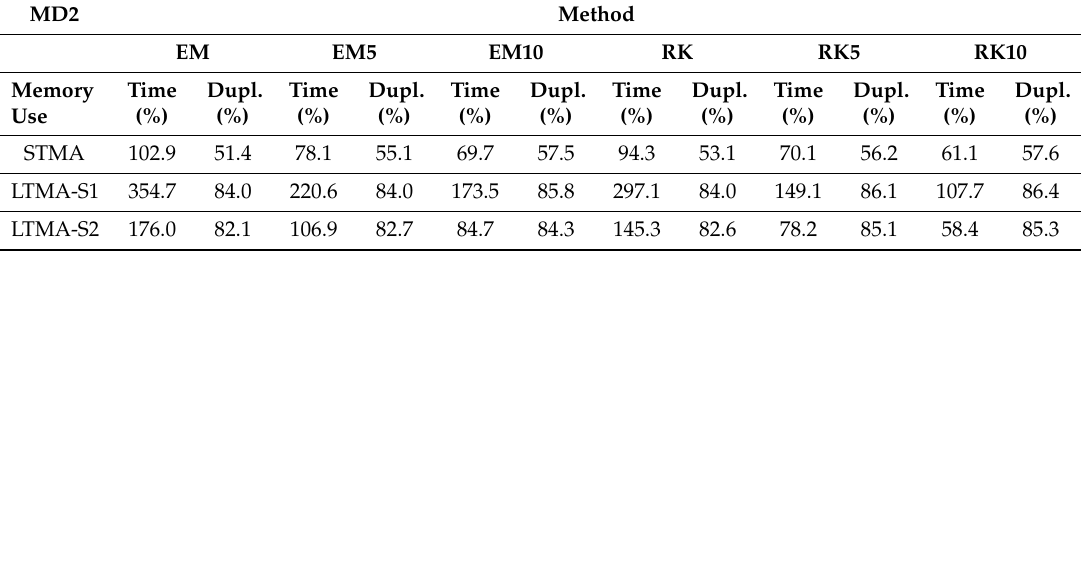
Table 31. Mean value of the calculation Times (Time) and Duplications (Dupl.) in respect to no additional memory use for 50 independent runs using EM, EM5, EM10, RK, RK5, and RK10 for MD2.